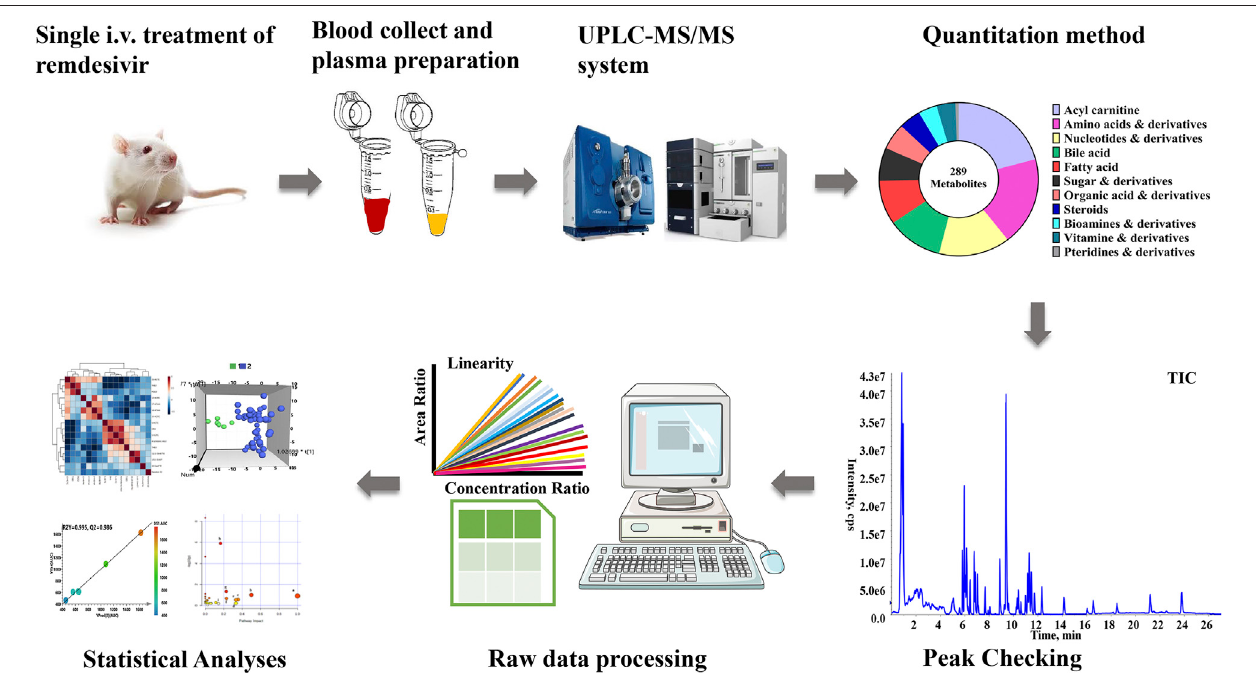
FIGURE 1 | Work fl ow of targeted metabolomics applied in this